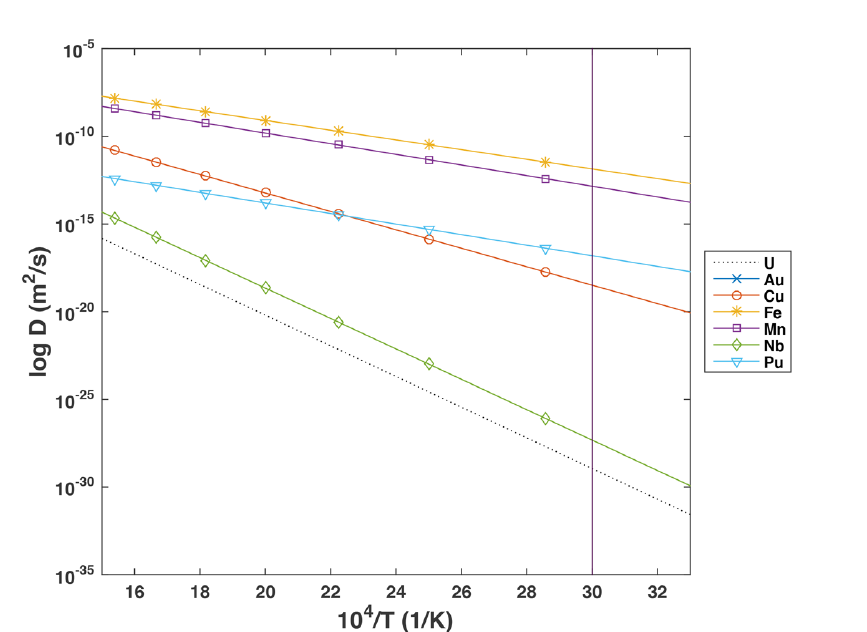
Figure 1. Diffusion coefficients of several interstitial solutes in U extrapolated to ambient temperatures. U self- diffusion is shown for comparison. [ 13